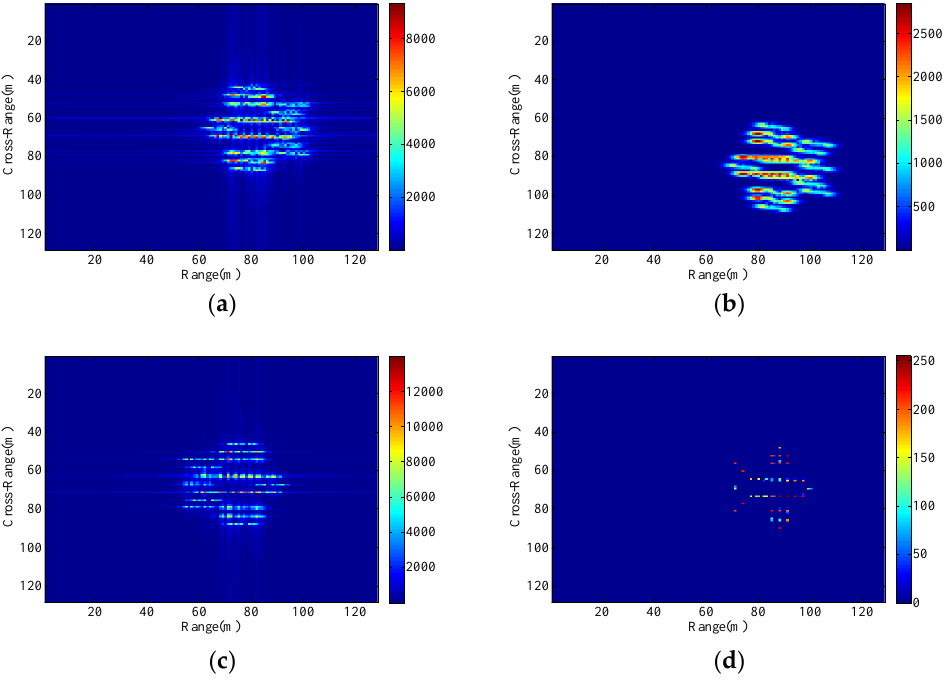
Figure 10. Imaging results with the radar platform vibration parameters P5. ( a ) RD algorithm; ( b ) cross-correlation method; ( c ) minimum entropy method; ( d ) the proposed method.